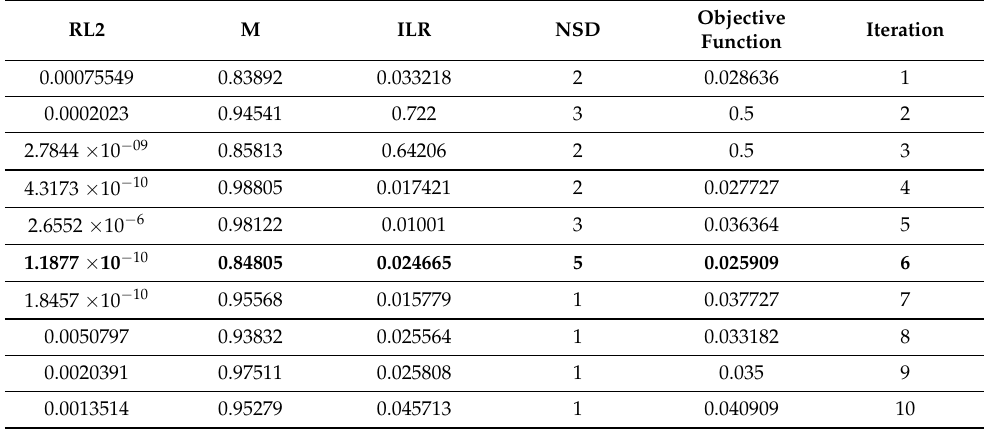
Figure 9. Training progress plot of the proposed CNN trained on fundus dataset in Experiment 1: ( a ) NO-CNN; ( b ) optimal BO-CNN of iteration #21. Table 4. Objective function evaluations and corresponding optimization variable estimates of the proposed CNN trained by OCT retinal images in Experiment 2. Entries of the optimal model are depicted in bold